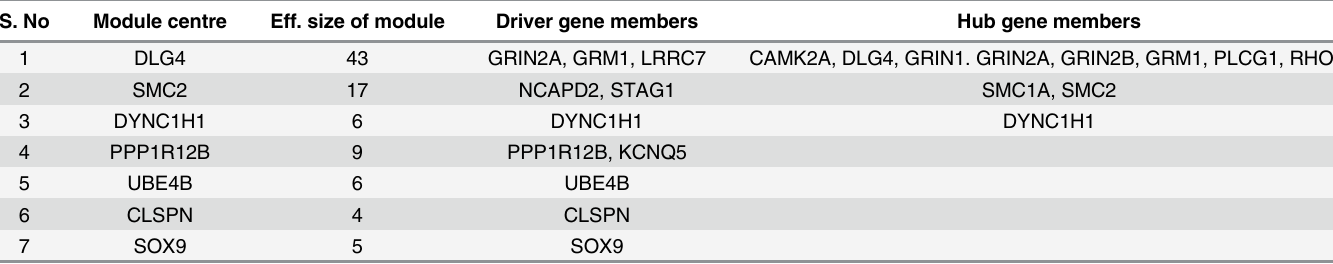
Each module is represented by its centre and effective size. Hub genes identi fi ed by centrality analysis and driver genes are indicated by their